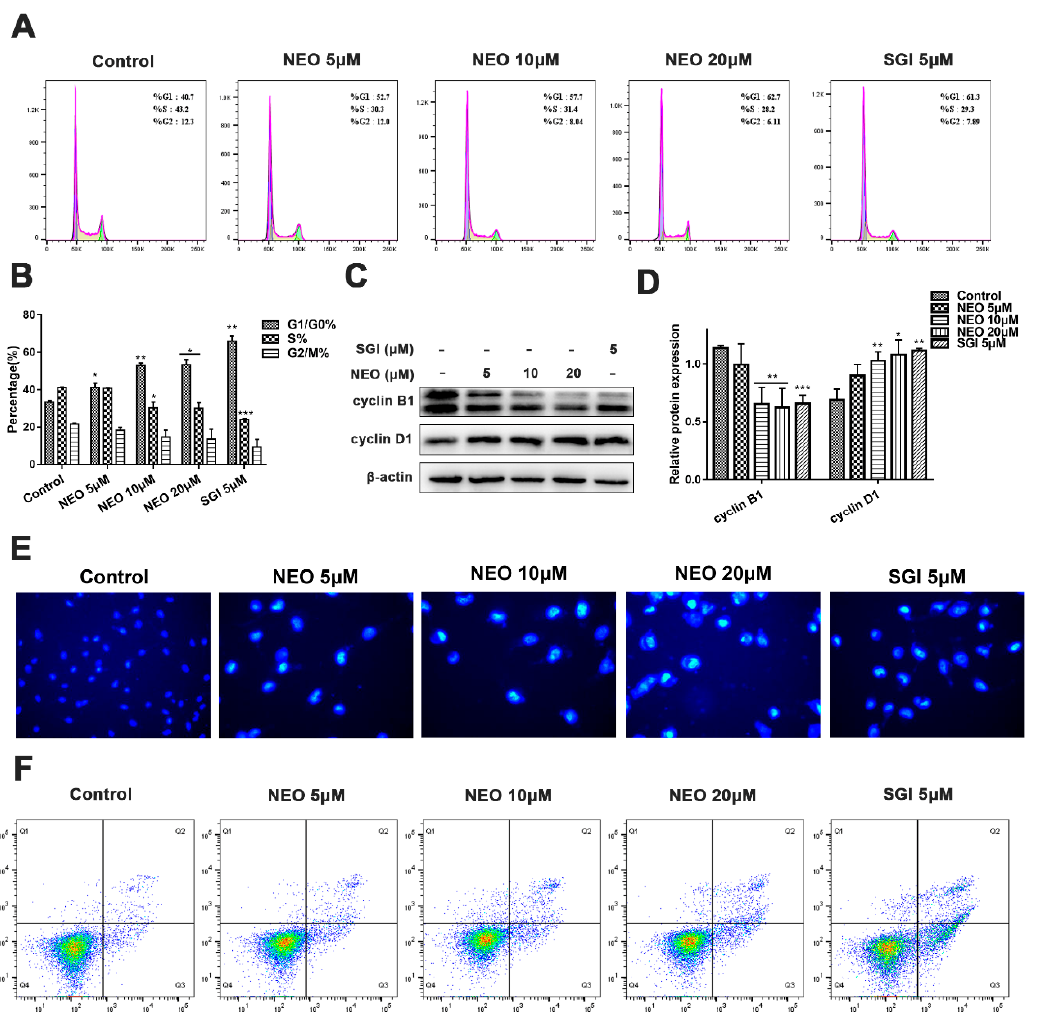
Figure 5. NEO and SGI-1776 induced cell cycle arrest and apoptosis of MDA-MB-231 cells. ( A , B ) Cell cycle distribution map of MDA-MB-231 cells treated with NEO and SGI-1776 for 24 h was detected by flow cytometry. NEO (concentration-dependent manner) and SGI-1776 significantly increased the ratio of cells in the G1/G0 phase. ( C , D ) Western blot image. Treatment of MDA-MB-231 cells with NEO for 24 h significantly down-regulated the expressions of cyclin B1 and up-regulated the expressions of cyclin D1. ( E ) MDA-MB-231 cells were treated with NEO and SGI-1776 for 24 h, stained with Hoechst 33258, and imaged. Cell apoptosis can be observed (magnification, ×200). ( F ) Apoptosis was detected by annexin V-FITC/PI staining. Treatment of MDA-MB-231 cells with NEO and SGI-1776 for 24 h induced apoptosis. Each value is the mean ± SD for n = 3. * p < 0.05, ** p < 0.01, *** p < 0.001 versus control group.